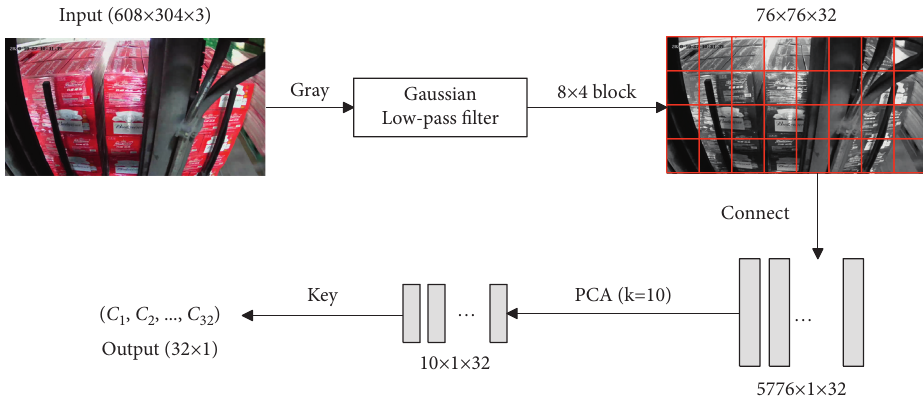
Figure 3: Image hash algorithm based on PCA.